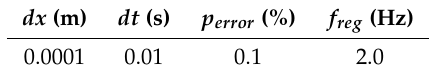
Table 2. Numerical parameters used for the